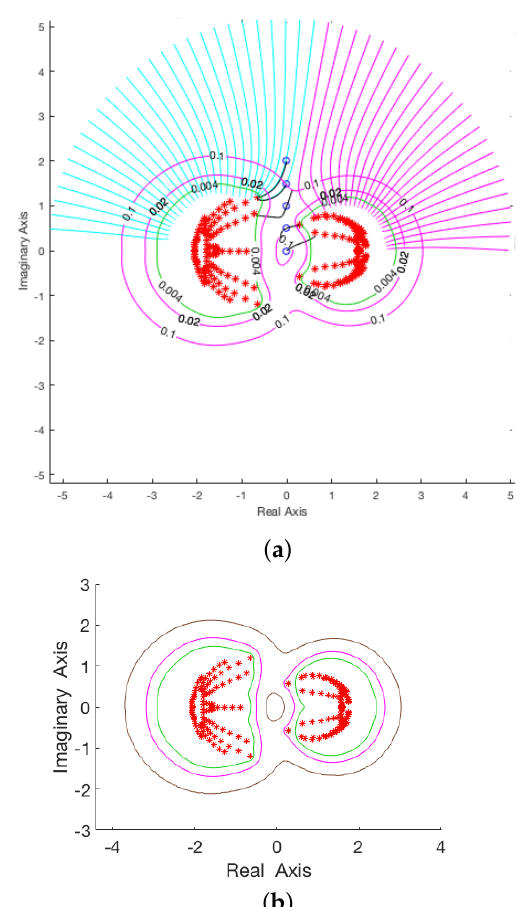
Figure 7. Comparison of pseudospectra computation for a damped gyroscopic system and (cid:101) = 0.004, 0.02, 0.1. ( a ) Computation using 50 initial points. ( b ) Computation using algorithm in